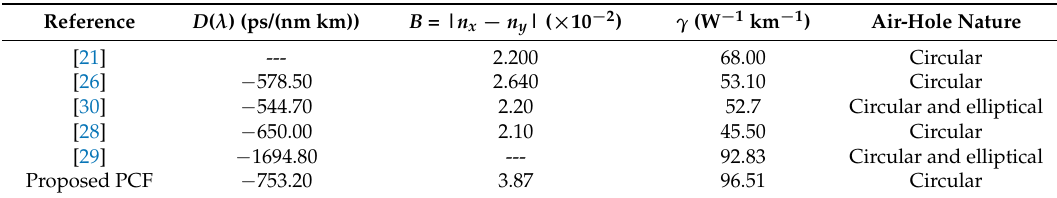
Table 1. Modal properties of the proposed photonic crystal fiber (PCF) in comparison with other PCFs at 1.55 µ